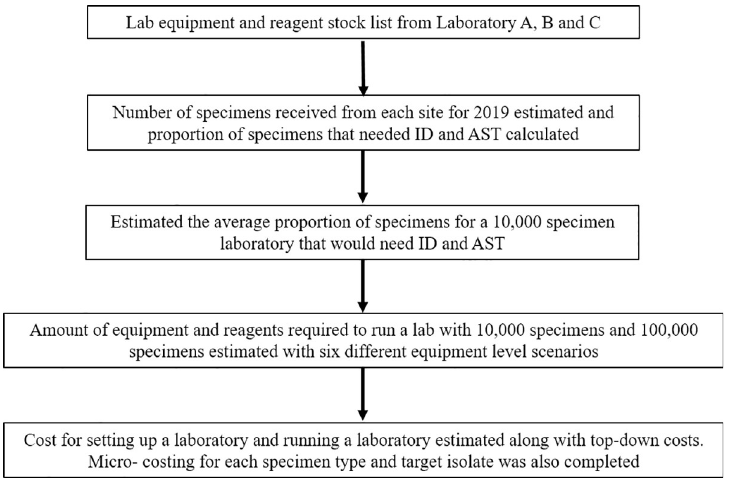
Fig 1. Flowchart of methods used to estimate the cost of setting up and running a microbiology laboratory in Southeast Asia.